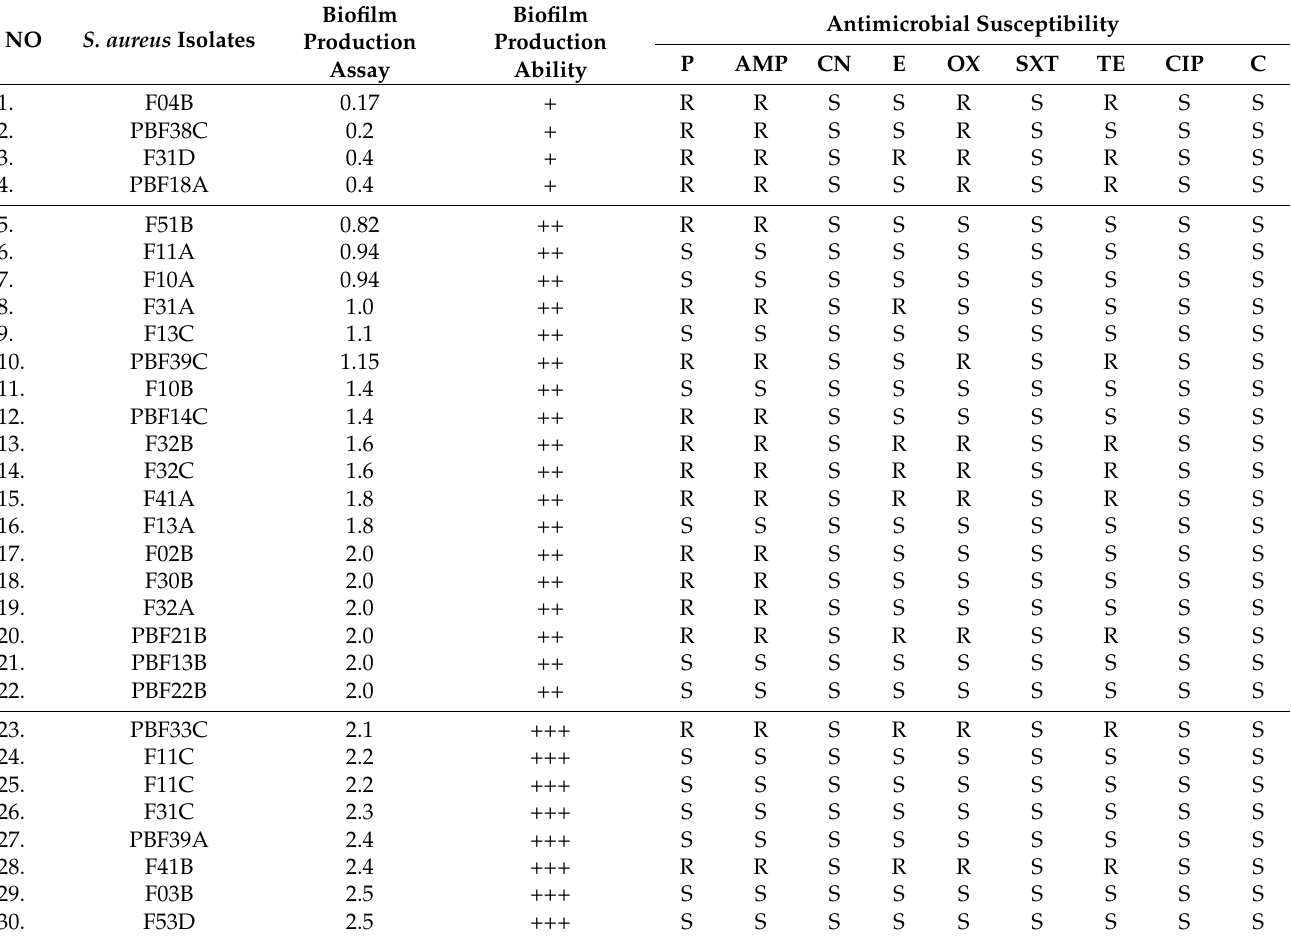
Table 4. Association between S. aureus biofilm formation and antimicrobial susceptibility